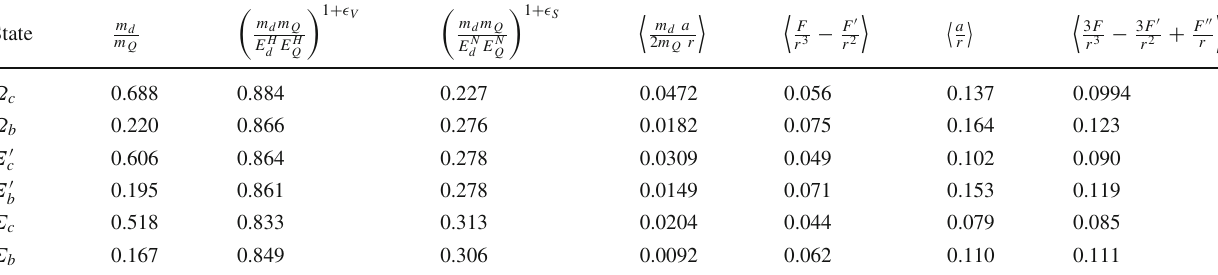
Table 11 Values of the relevant factors (dimensionless) and the computed averages (in GeV − 3 ) for spin coupling a 1 , 2 and b in Eq. (40)